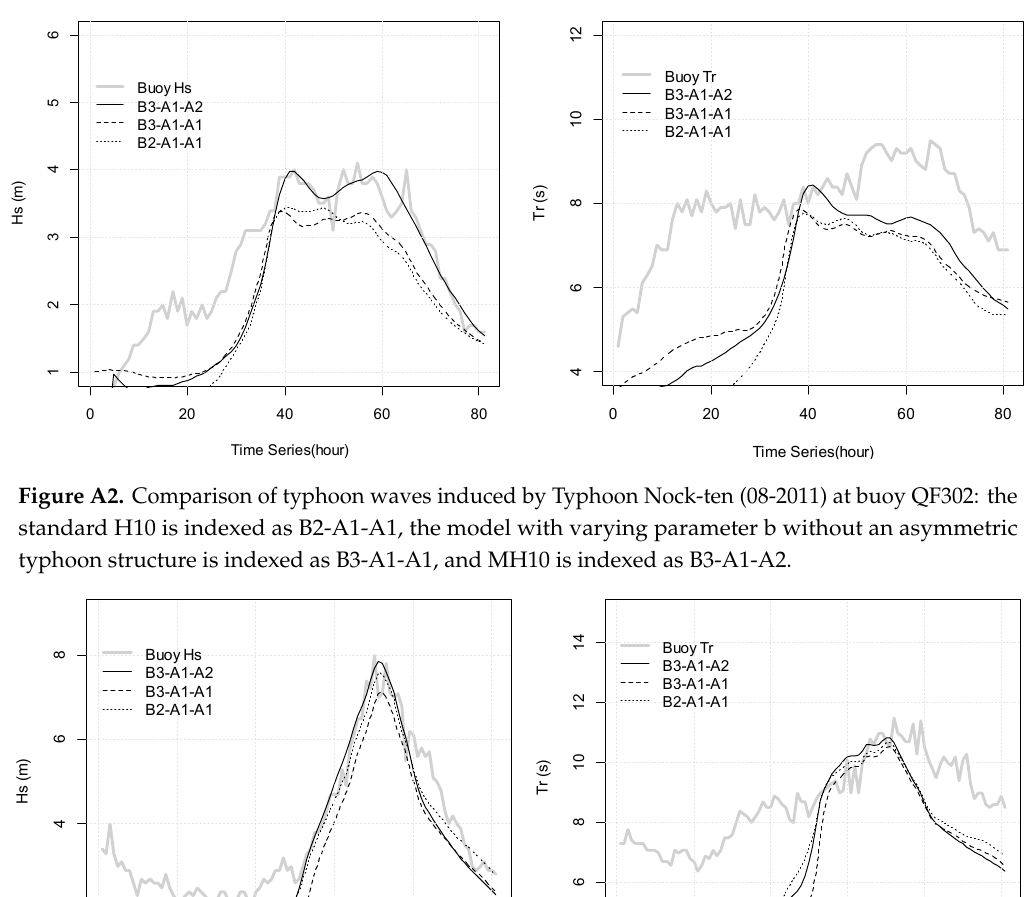
Figure A1. Comparison of typhoon waves induced by Typhoon Chanthu (03-2010) at buoy QF303: the standard H10 is indexed as B2-A1-A1, the model with varying parameter b without an asymmetric typhoon structure is indexed as B3-A1-A1, and MH10 is indexed as B3-A1-A2.